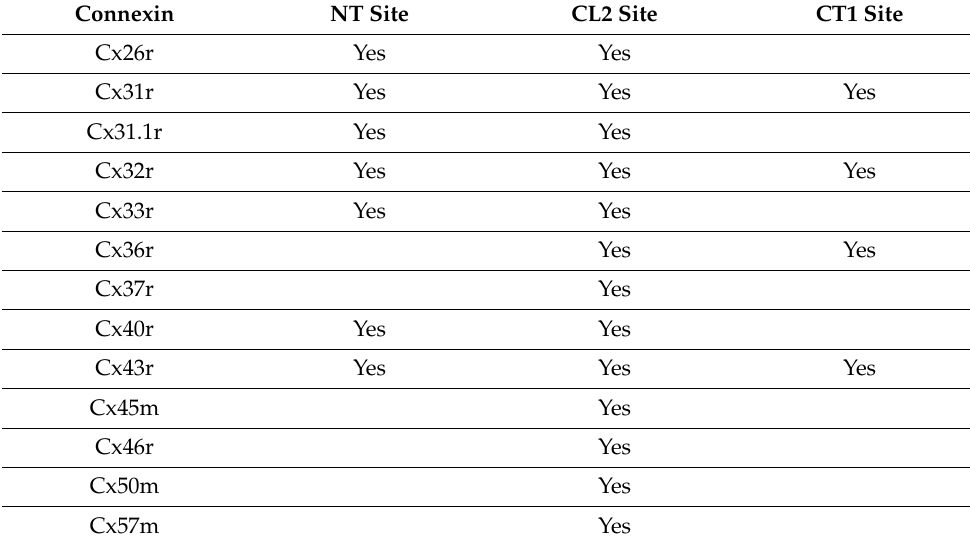
Table 1. Predicted CaM-binding sites in